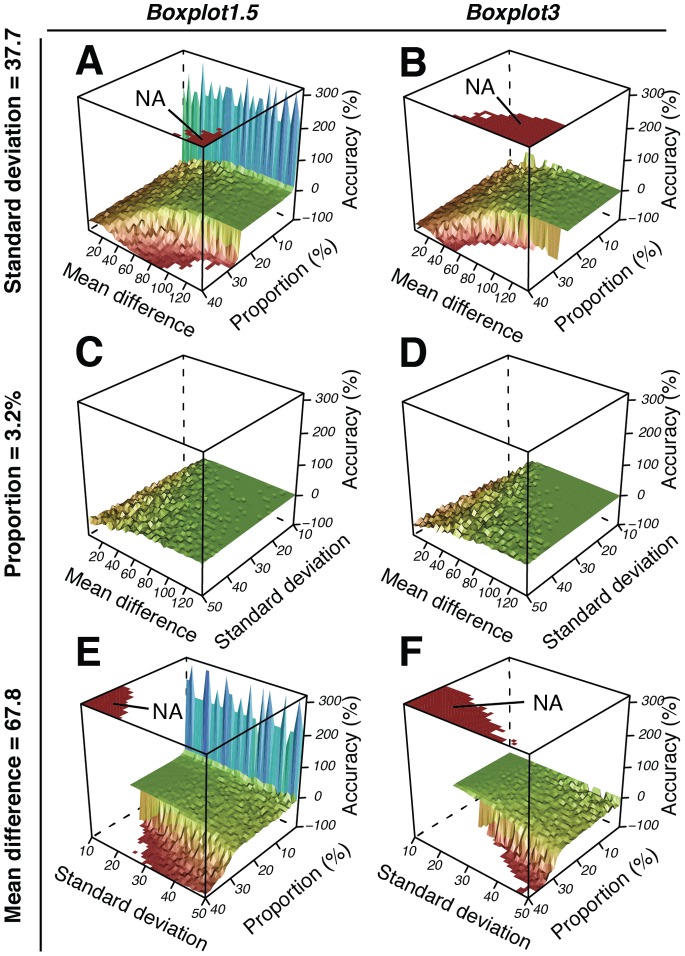
3D surfaces of simulation data showing the accuracy (z axis) in the estimated compared to the true subpopulation size using two different methods of population separation: Boxplot1.5 and Boxplot3.Accuracy is shown as a function of different population mixtures (1600 per plot), with subpopulations either varying in mean differences (range: 2–137; n = 40; x axis) and proportions (range: 0.1–40%; n = 40; y axis) at a constant standard deviation (37.7) (A, B), or varying in mean differences (range: 2–137; n = 40; x axis) and standard deviations (range: 10–50; y axis) at a constant proportion (3.2%) (C, D), or with varying standard deviations (range: 10–50; n = 40; x axis) and proportions (range: 0.1–40%; n = 40; y axis) at a constant mean difference (67.8) (E, F). Accuracy is expressed as the percent difference between calculated and real subpopulation size, and therefore indicates the normalized deviance of the calculated subpopulation size from the real subpopulation size. A negative value indicates that the method underestimated the subpopulation size. A positive value indicates an overestimated result. A value of zero indicates absolute accuracy. A smooth surface of the same colour/grey-level indicates a robust separation. NA, missing values.